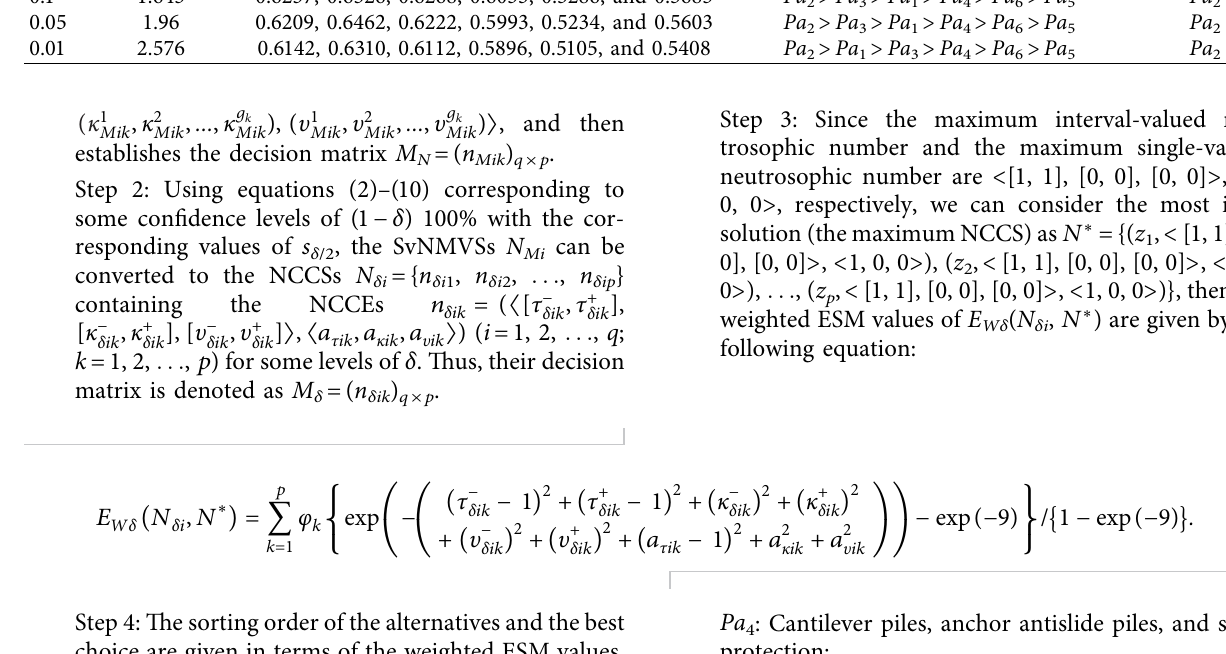
Sorting order Optimal